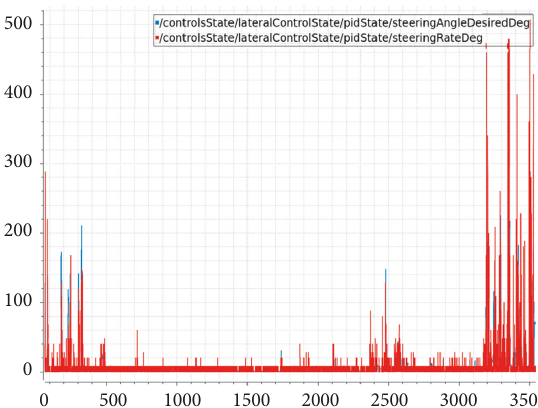
Figure 59: T2N2 steering degrees.